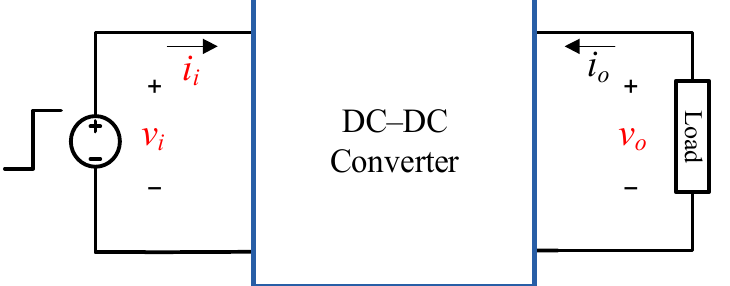
Figure 5. Input voltage step change-based measurement setup for input admittance and audiosus- ceptibility.